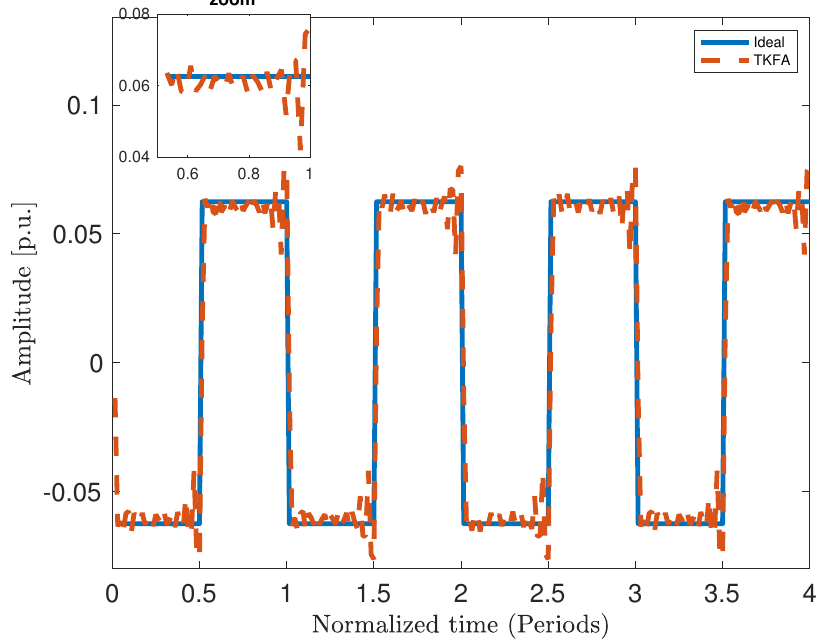
Figure 4. Derivative approximation to the input signal with TKFA